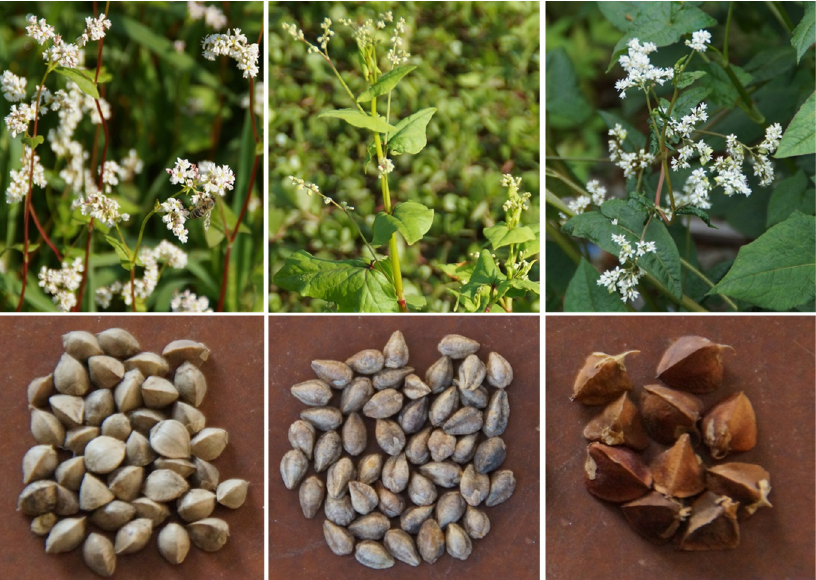
Figure 1. From left to right: plants and grain of common buckwheat, Tartary buckwheat and cymosum buckwheat. Height of plants is normally up to 1.2 m, and grain size is 4 to 6 mm.